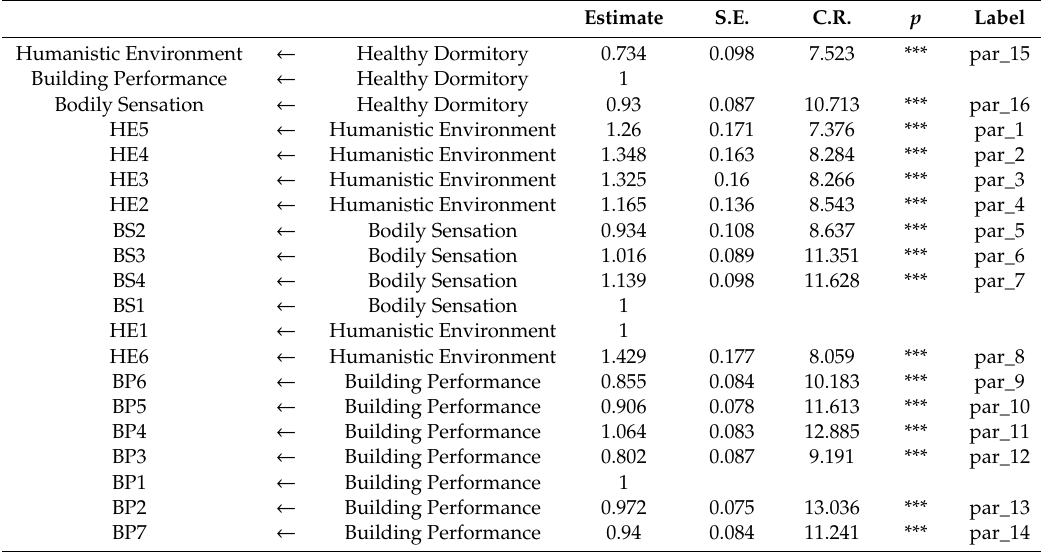
Table 5. Regression weights of the second-order confirmatory factor analysis.